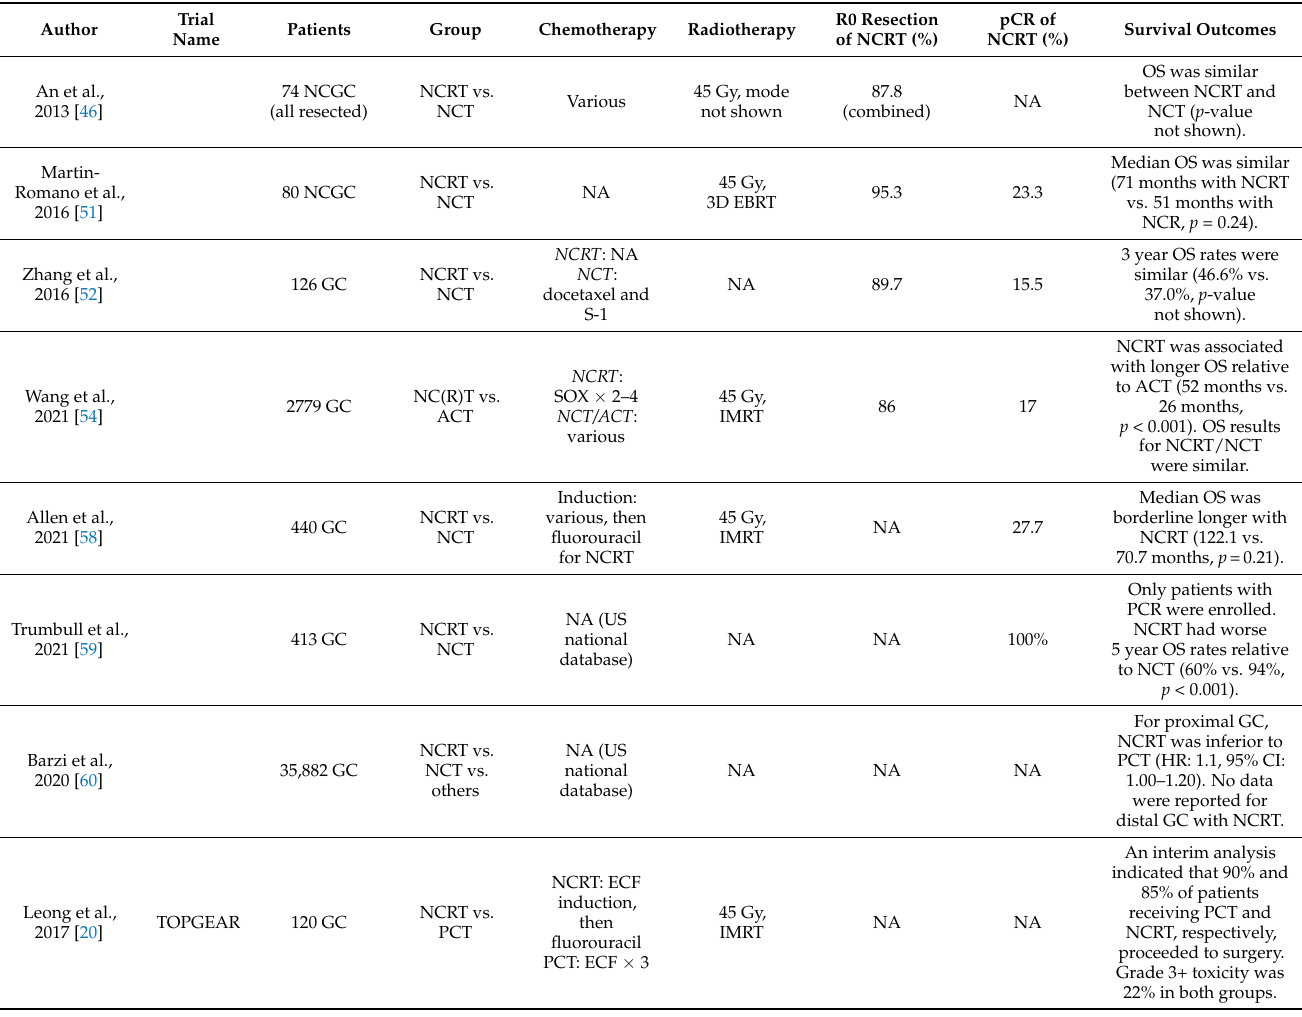
Table 3. Studies examining neoadjuvant chemoradiotherapy (NCRT) for locally advanced gastric cancer